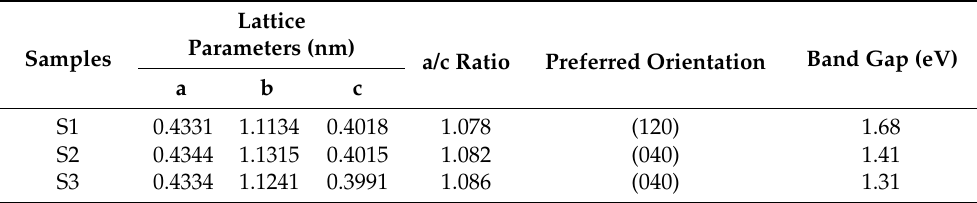
Figure 2. ( a ) XRD patterns of the SnS nanosheet samples; ( b ) ( α hv ) 2 versus hv : direct band gap. The sample lattice parameters of the SnS nanosheets are presented in Table 1. The S3 lattice parameters are most similar to the corresponding standard JCPDS data; specifically, the a/c ratio (1.086) was approximately equal to 1.085, i.e., the standard SnS. This might be due to the film density, and this might be dependent on the crystallite size. When the sheets become small and uniform, the lattice dimensions are distinct from those of the chemically identical materials. When SnCl 2 · 2H 2 O is the tin source, compared with SnCl 4 · 5H 2 O in the same condition, the SnS lattice parameters may increase slightly. Table 1. SnS nanosheet sample lattice